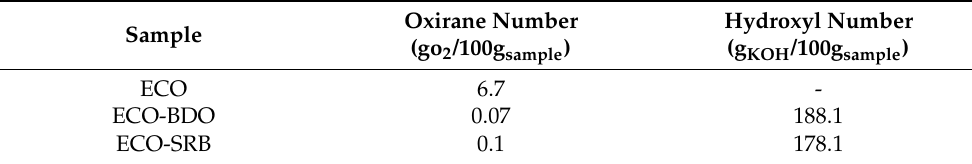
Table 2. Characterization of the derivatives of the cardoon seed